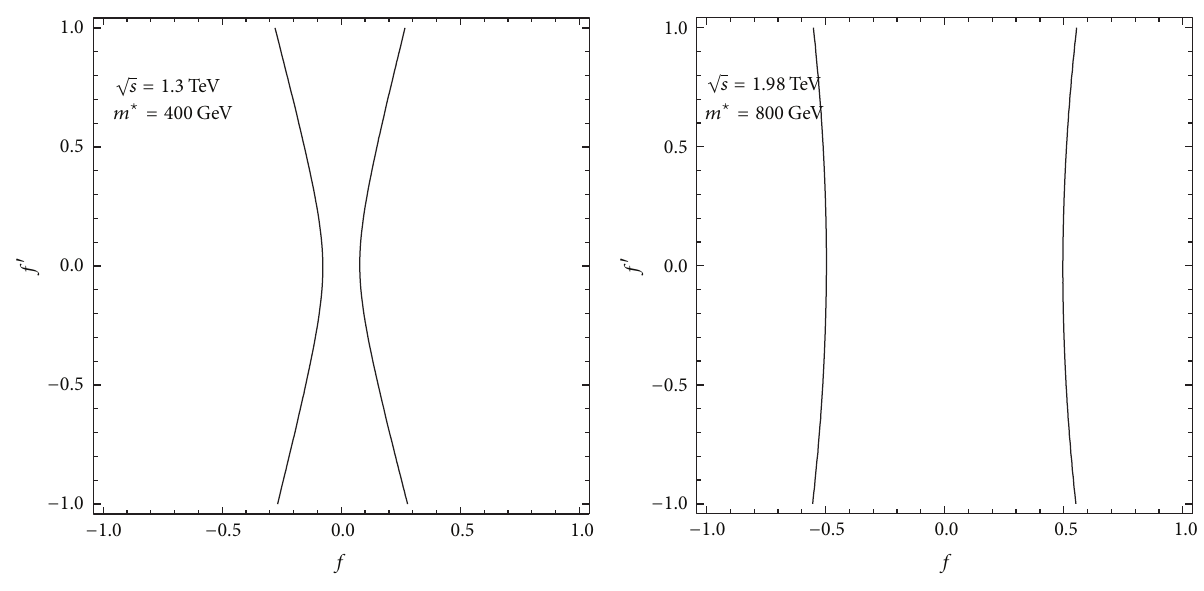
Figure 9: Contour plots for excited spin-1/2 neutrinos.